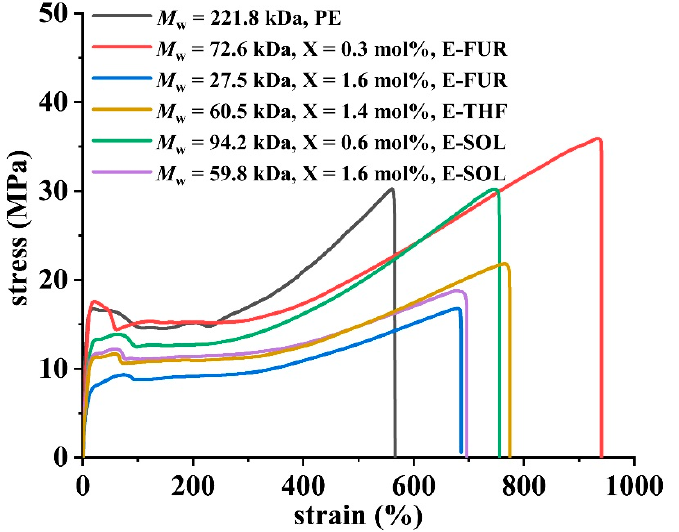
Figure 4. Stress–strain curves for selected functionalized polyethylene samples and a non-polar polyethylene sample generated by Pd-3 .